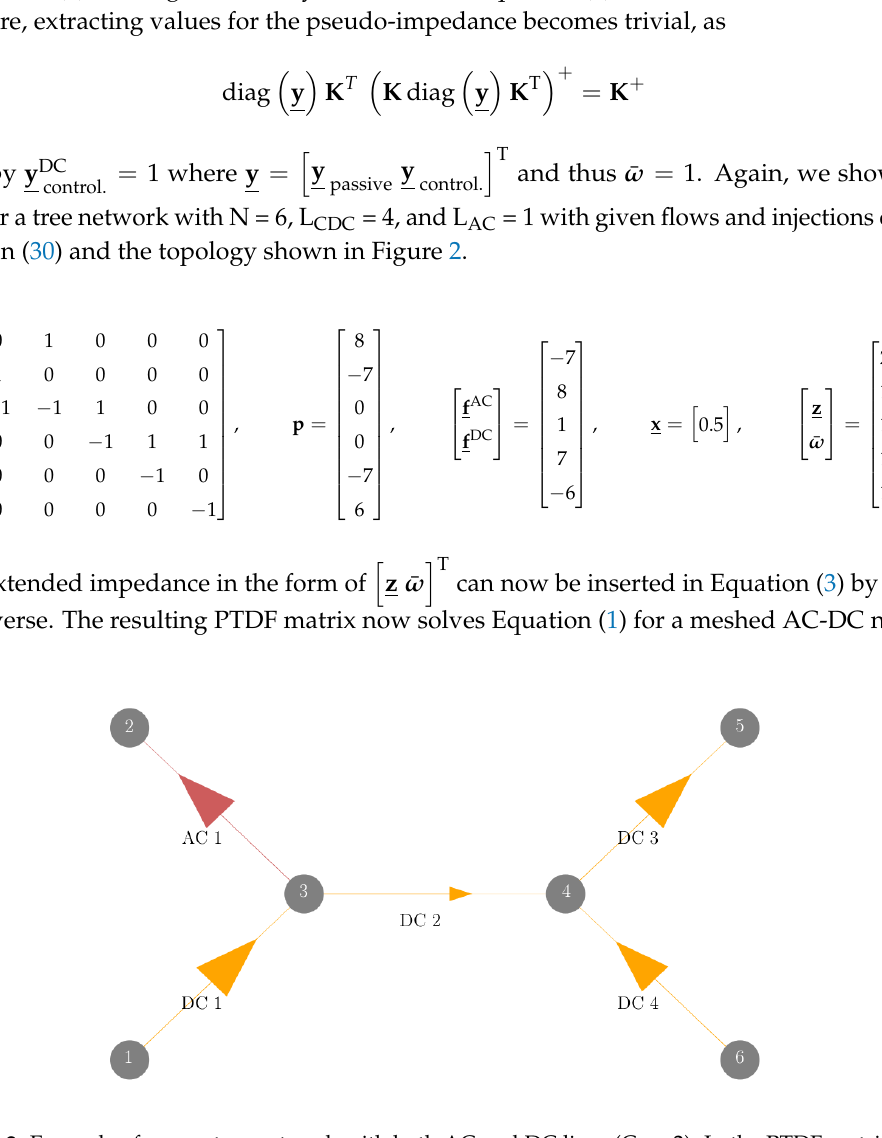
Figure 2. Example of a pure tree network with both AC and DC lines (Case 2). In the PTDF matrix, the pseudo-impedance values for the DC lines are trivially equal to 1 for the given flow